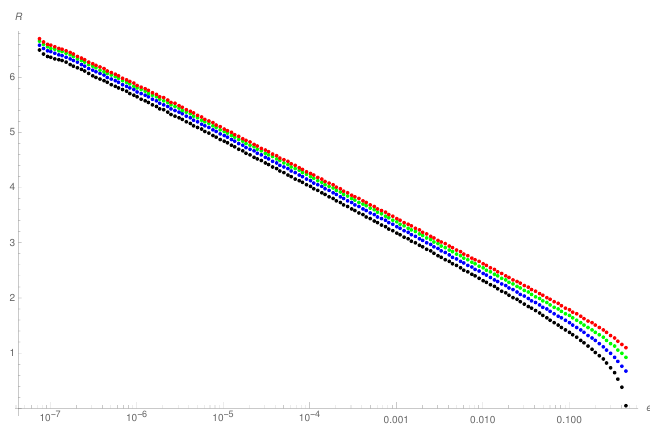
Figure 5 . Distance between the quarks (string endpoints) for a single loop ( I ), as a function of dimensionless separation of the tip of the loop from the wall (cid:15) = ( z B (cid:0) z (cid:3) ) =z (cid:3) . Plots are given for di(cid:11)erent values of the quark massess: from bottom to top, black m = 1 : 31, blue m = 2 : 03, green m = 3 : 55 and red m = 9 : 5.